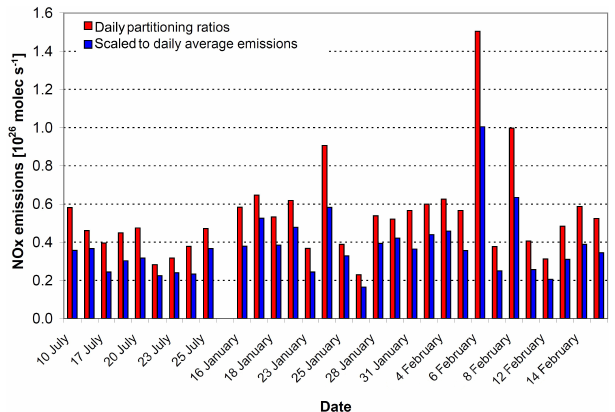
Figure 15. Comparison of the derived emissions from CHIMERE model simulations for either the periods of the individual measure- ments or scaled to daily averages. Days with uncertainties in the car MAX-DOAS measurements>100% and with ratios of the CIM re- sults for CHIMERE and TNO emissions above 1.7 and below 0.6 are left out.